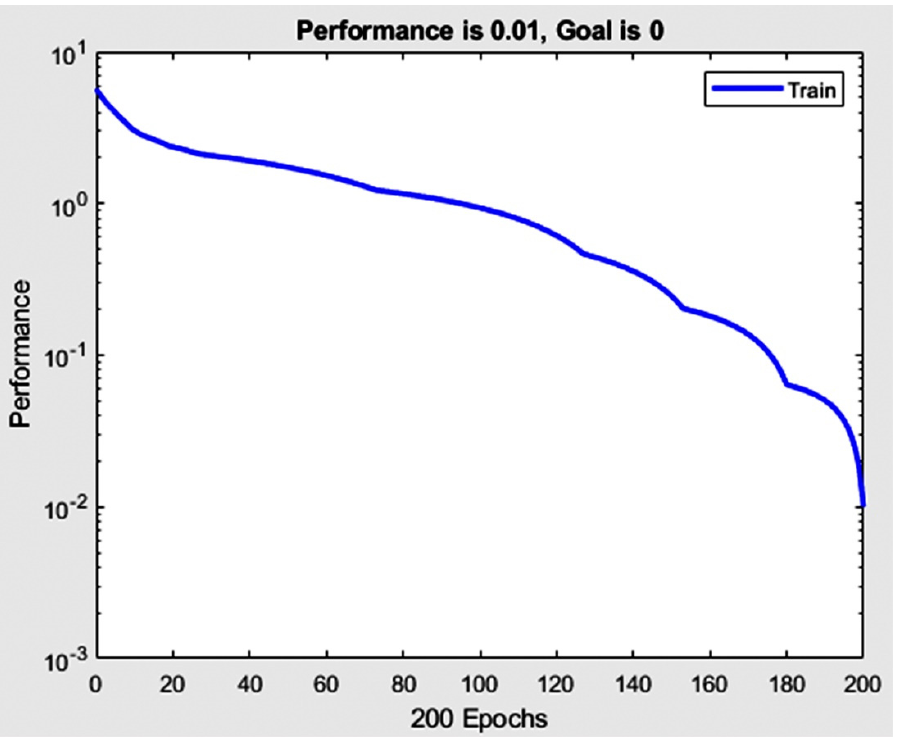
Figure 11. Performance of training for Duval_Pentagon_2_RBFNN.